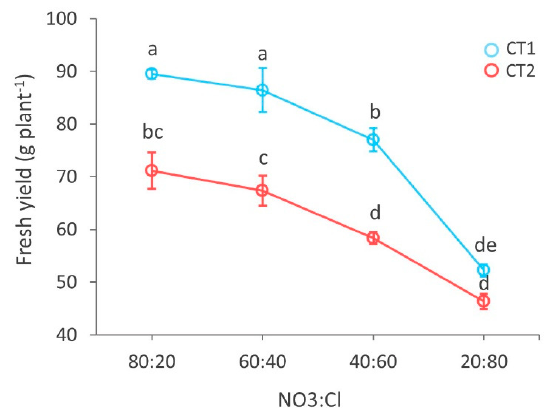
Figure 2. Main e ff ect of the NO 3 − :Cl − ratio in the nutrient solution in the two harvests (CT1, azure; CT2, salmon) on fresh yield of basil. Di ff erent letters indicate significant di ff erences according to Duncan’s test ( p = 0.05). All data are expressed as mean standard error, n = 3.